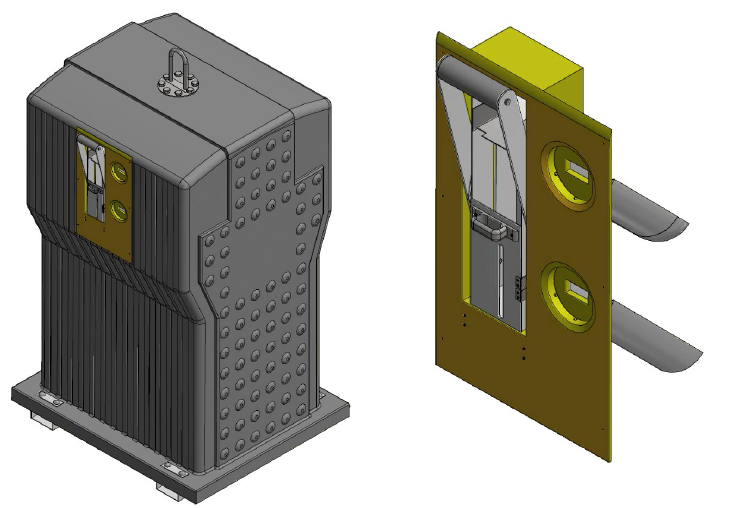
Figure 7. Proposal of a new Cyclea model with a compaction system for selective collection of metals and plastics in one single container [1,46].